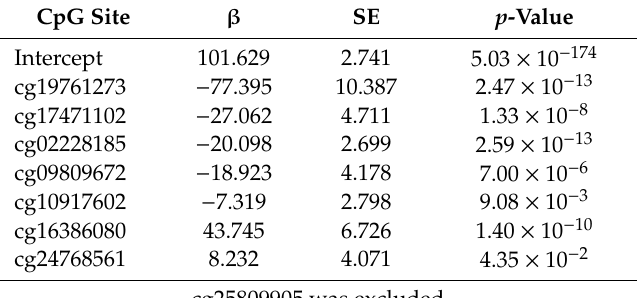
Table 2. Model for the estimation of the DNA methylation age, resulting from the stepwise multiple linear penalized regression analysis with chronological age as the dependent variable ( n = 785).